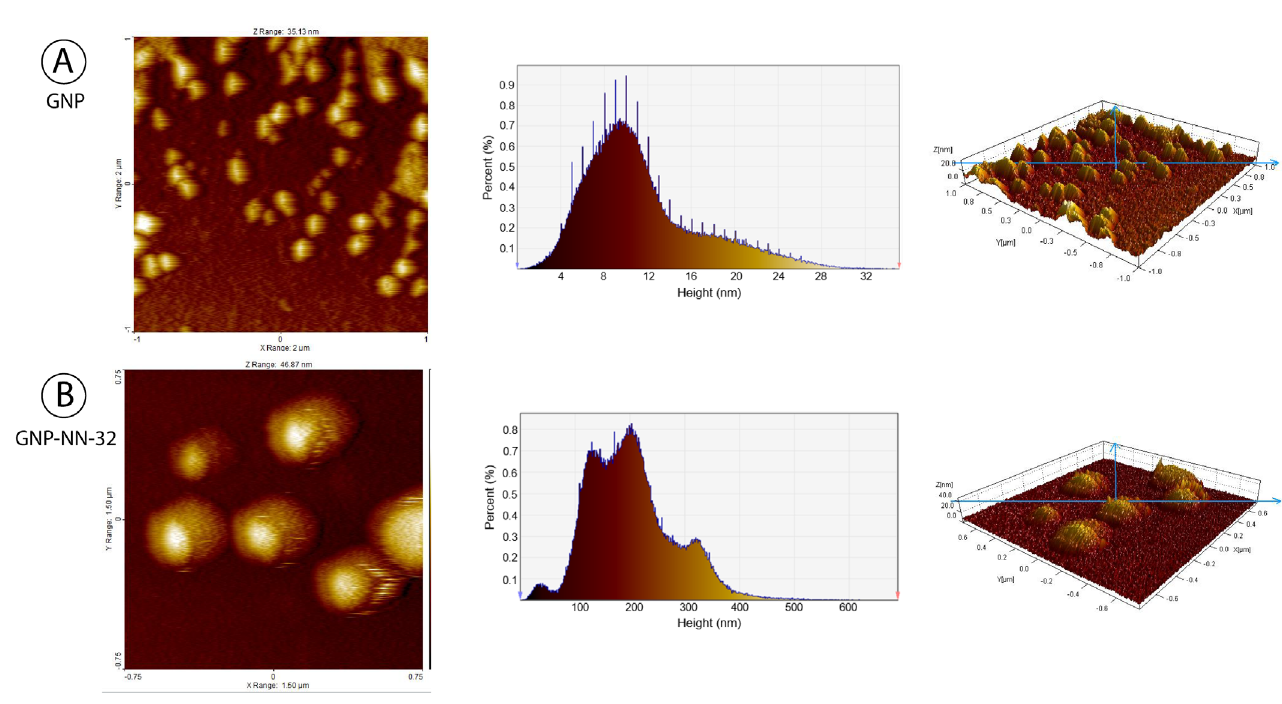
Figure 4. Characterization of GNP-NN-32 by AFM. (A) GNP, (B) GNP-NN-32.